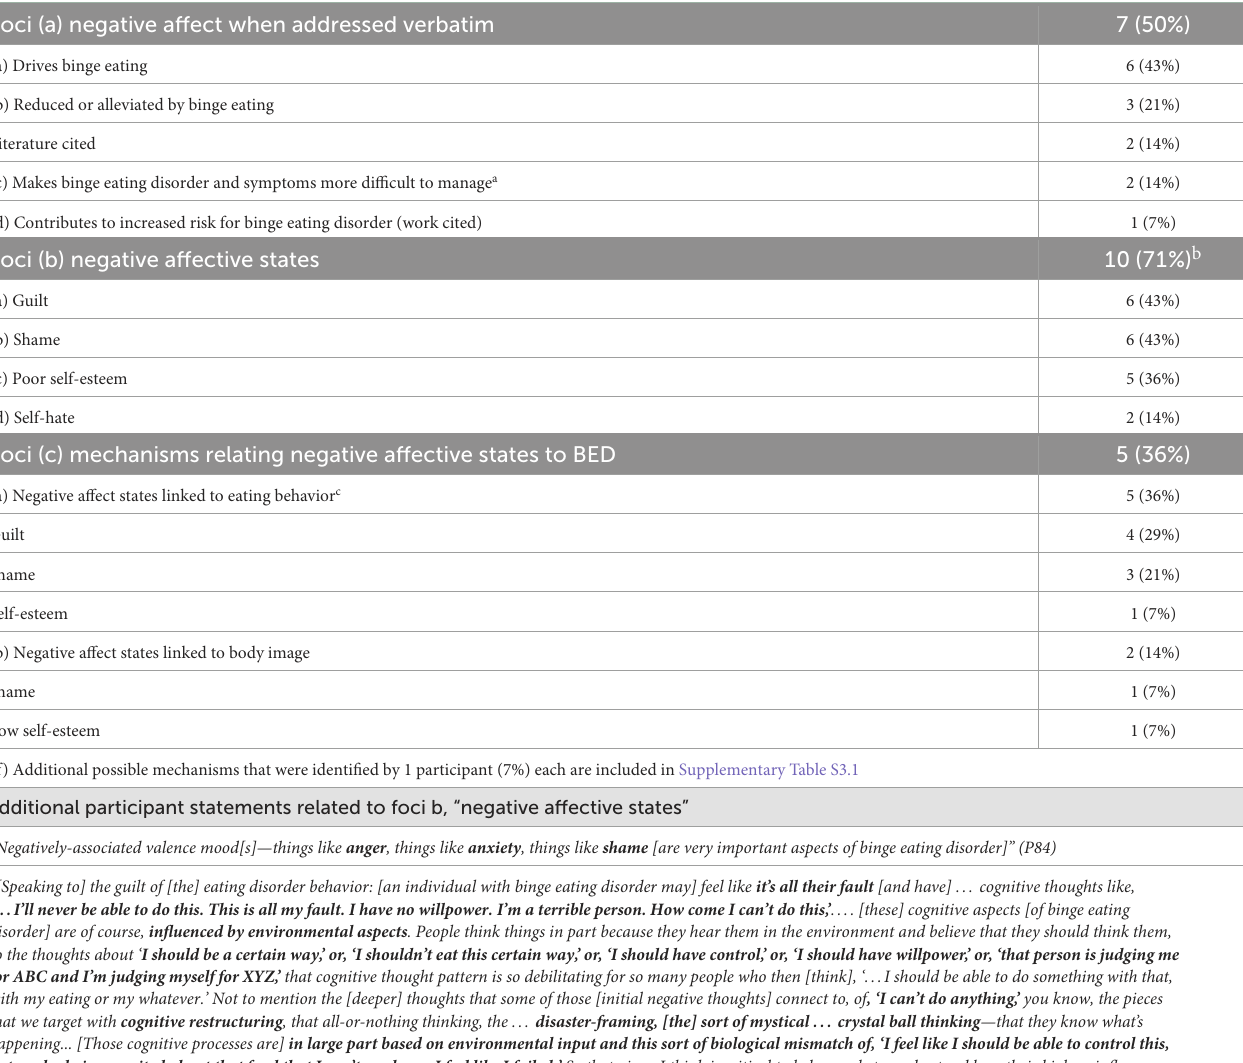
TABLE 8 Participant statements consistent with theme 3, subtheme i, “negative